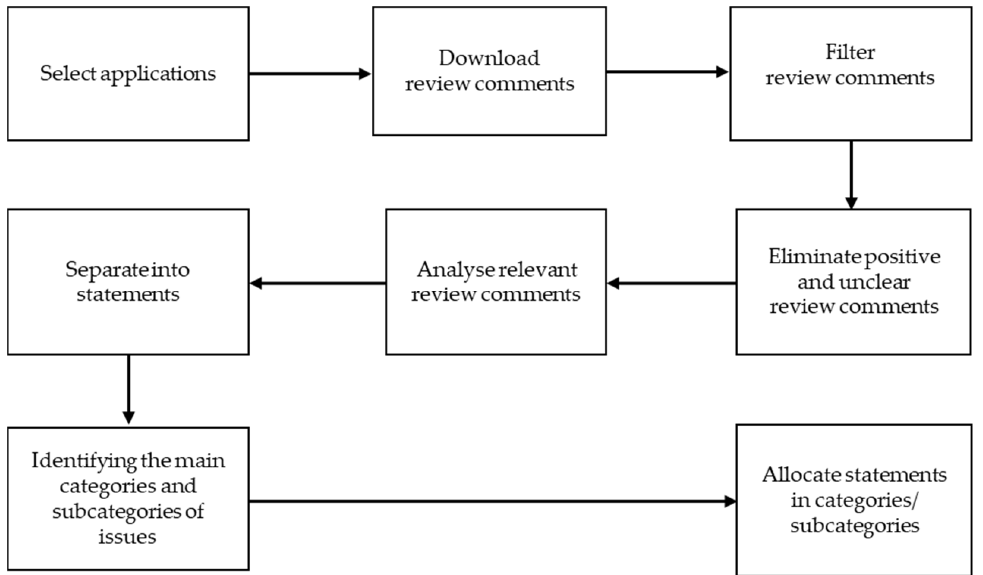
Figure 1. Study design. Source: own construction.